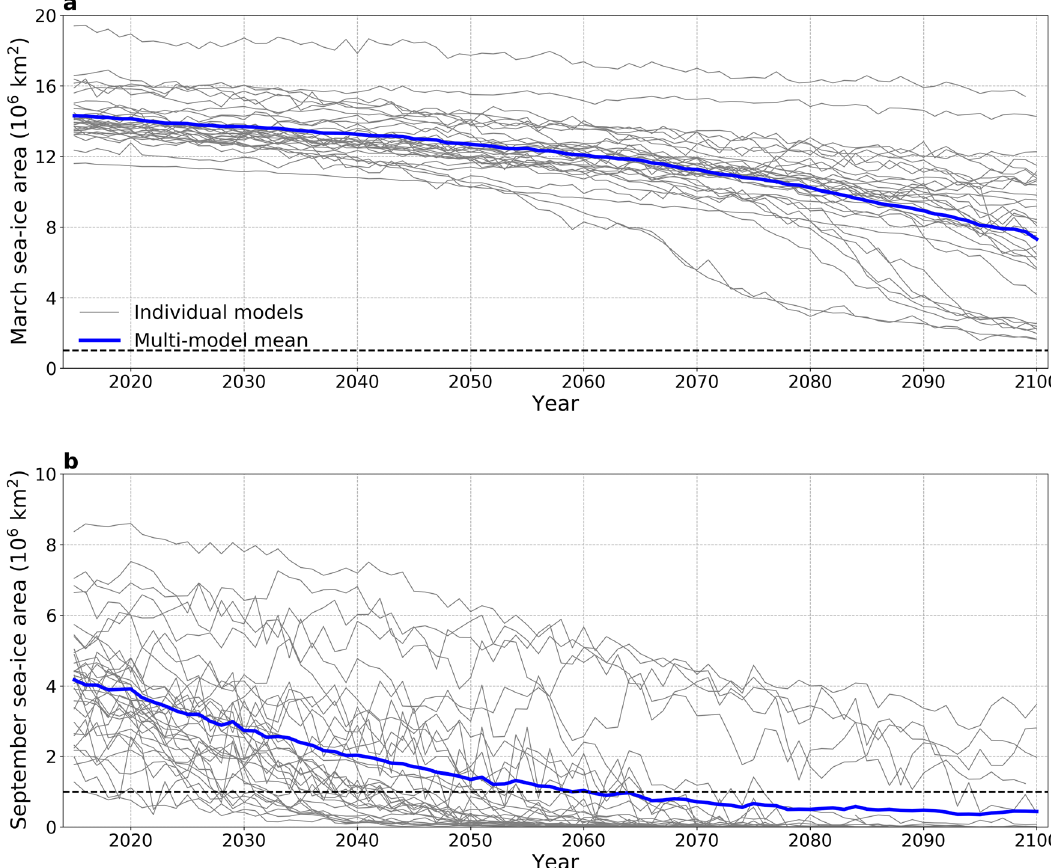
Fig. 1 Time evolution of future Arctic sea-ice area in CMIP6 models. Time evolution is provided for individual model ensemble means (thin grey curves) and the multi-model mean (thick blue curve). a March and ( b ) September Arctic sea-ice area based on the SSP5-8.5 scenario. The horizontal dashed line represents the ice-free Arctic